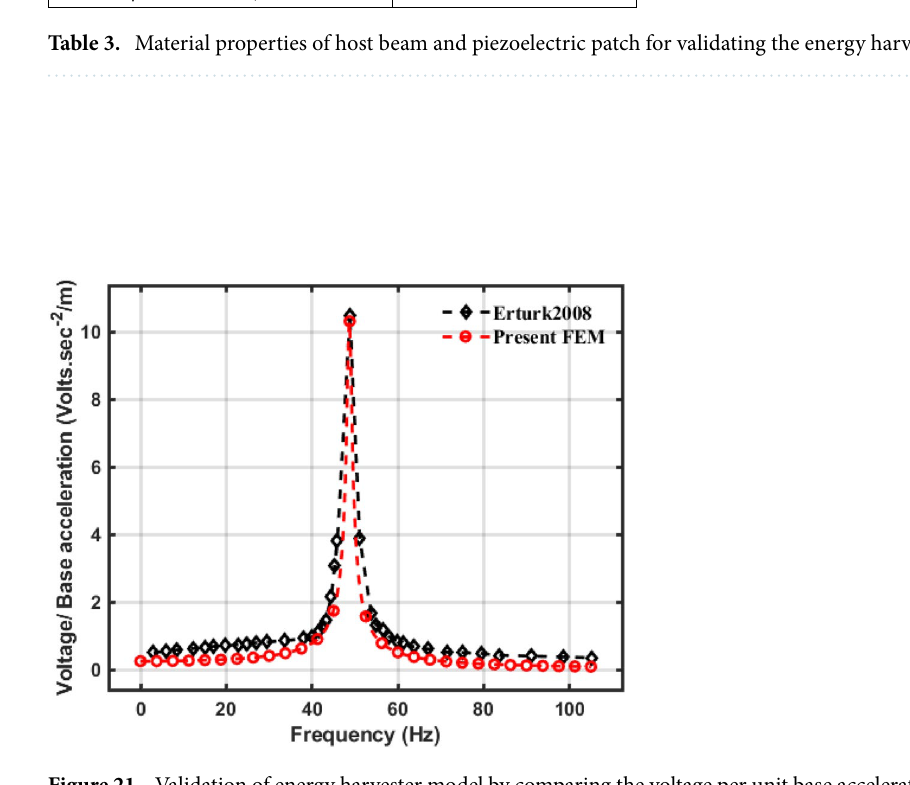
Figure 21. Validation of energy harvester model by comparing the voltage per unit base